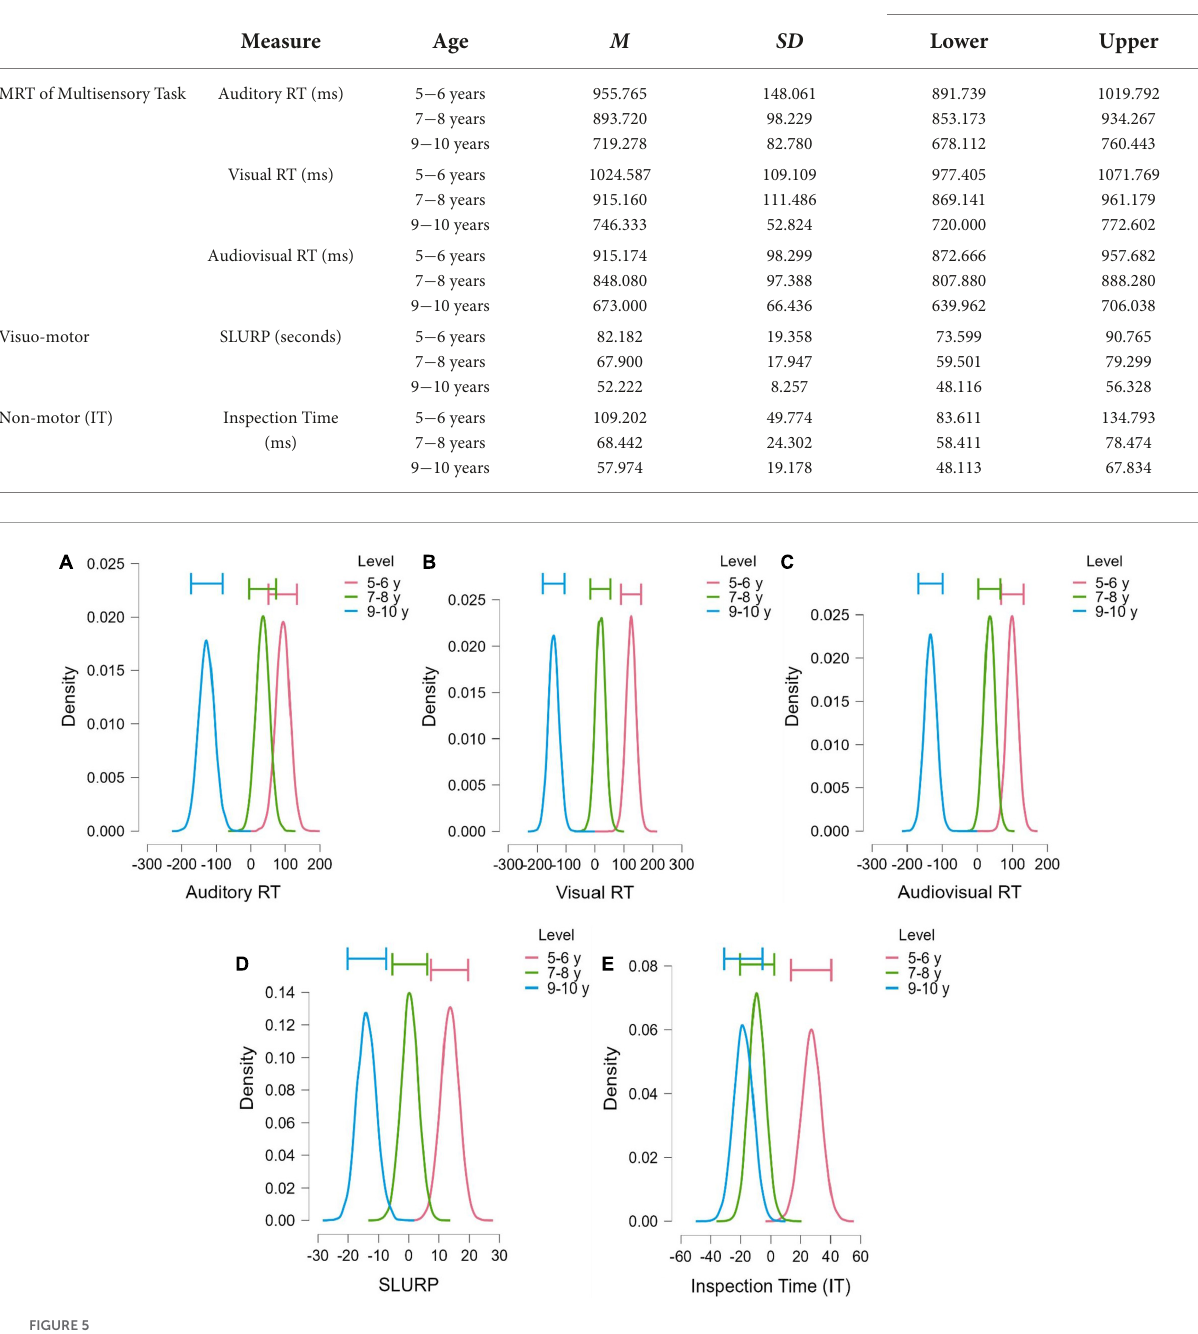
TABLE 2 Descriptive statistics for auditory RT, visual RT and audiovisual RT, visuomotor, and visual perceptual processing by age groups.